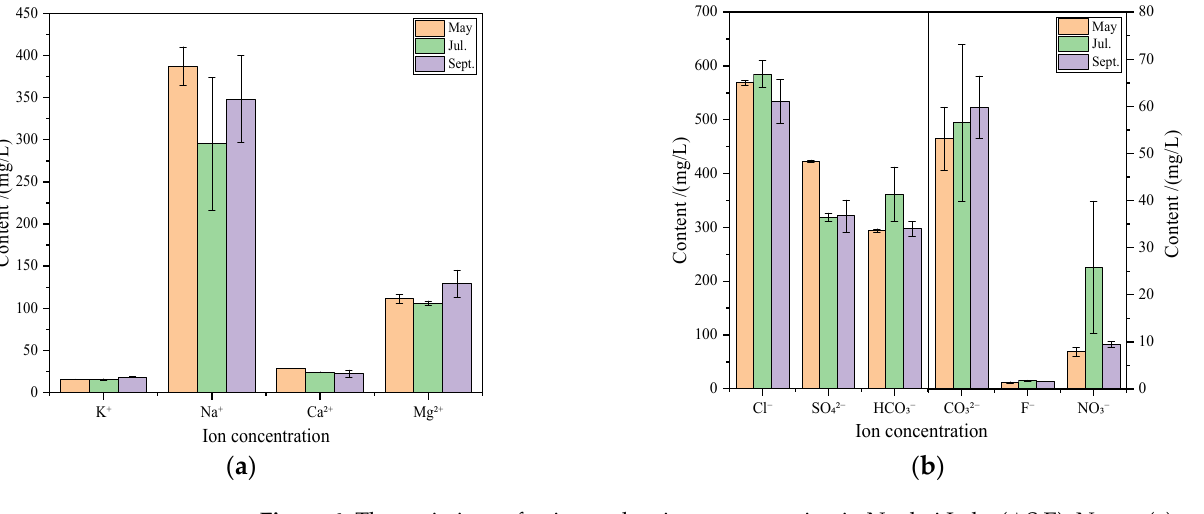
Figure 6. The variations of anion and cation concentration in Nanhai Lake (±S.E). Notes: ( a ): anion content in May, July, and September; ( b ): cation content in May, July, and September. Table 4. The variations of heavy metal concentration in Nanhai Lake (mean ±